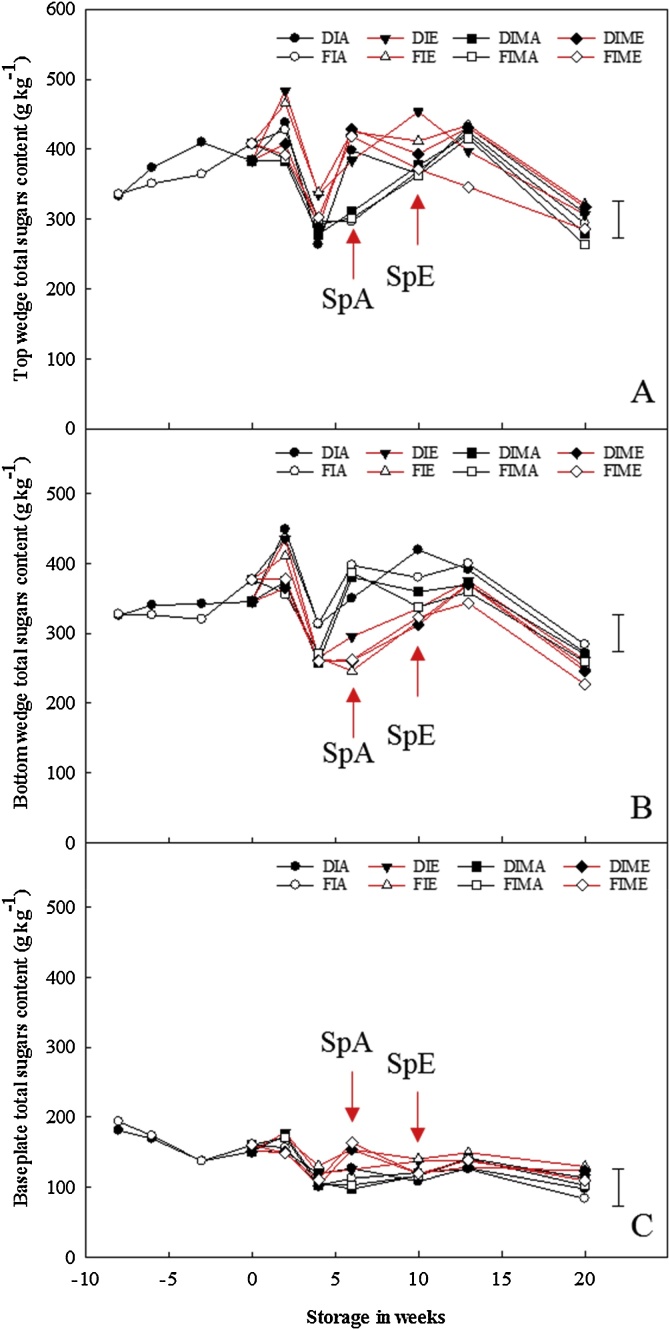
Pre- and postharvest total sugar content in the top section, bottom section and baseplate of stored onion bulbs treated with and without 1-MCP and ethylene. Total fructans contents (sum of fructose glucose and sucrose content) per dry weight for the top wedge (A), bottom wedge (B) and baseplate (C) of onion bulbs of cultivar ‘Sherpa’ grown in 2016 under full irrigation (FI) or deficit irrigation (DI); where FI amounted to 100% replenishment of crop evapotranspiration (ETc) and DI was ETc replenishment at 50%. Bulbs were harvested at full maturity (100% fall-down) and cured under glass for six weeks for both years. Post-curing, bulbs were treated with 1-MCP at 1 μL L−1 for 24 h before storage or untreated with 1-MCP, and were stored at 1 °C under continuous ethylene supplementation at 10 μL L-1 or air. DIMA and FIMA are DI and FI bulbs treated with 1-MCP and stored in air and DIME and FIME are DI and FI bulbs treated with 1-MCP and stored under ethylene. SpA and SpE are sprout emergences for bulbs stored in air and ethylene, respectively. Where pre-harvest = –8; harvest = –6; mid-curing = –3; and end of curing = 0 in weeks. LSD bar at 95% confidence shown.